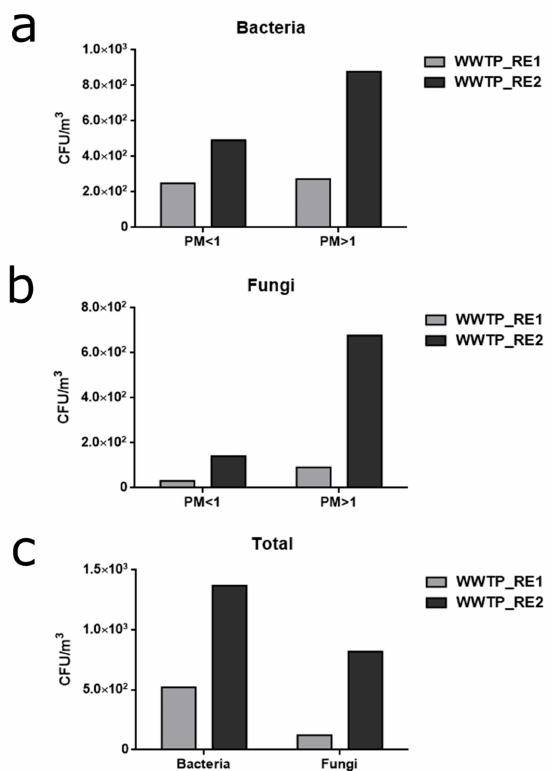
Figure 7. Cultivable microbial charge derived from the filters of the two subsequent samplings of WWTP_RE1 and WWTP_RE2. ( a ) Bacteria colony forming unit (CFU) / m 3 obtained on NB agar plates by washing the sampled filters. Amounts for fine (PM < 1) and coarse fraction (PM > 1) are reported for each sampling. ( b ) Fungi CFU / m 3 obtained on yeast extract peptone dextrose (YPD) agar plates by washing the sampled filters. Amounts for fine (PM < 1) and coarse fraction (PM > 1) are reported for each sampling. ( c ) Total amount of collected CFU / m 3 of bacteria and fungi in the WWTP_RE1 and WWTP_RE2